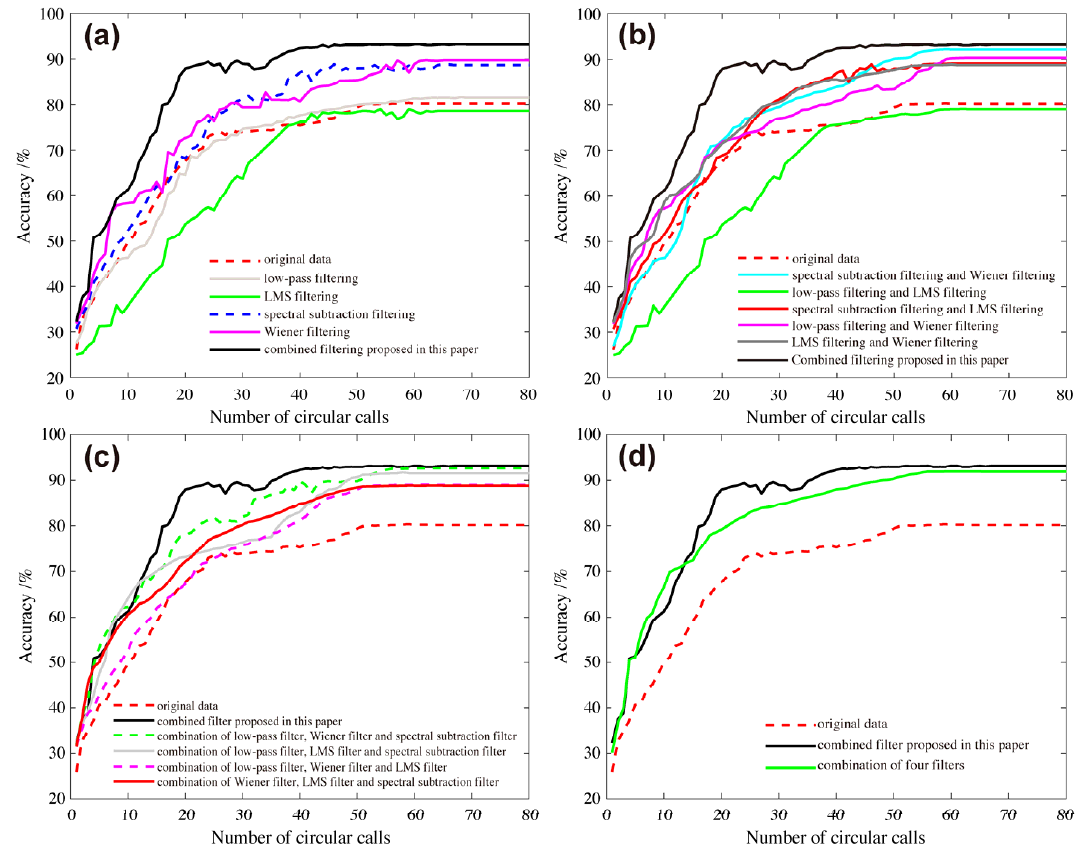
Figure 9. ( a ) Accuracy of thunder recognition using different filters and a combined spectral subtrac- tion filter with a low-pass filter, and ( b – d ) similar to ( a ) but for the results using combinations of two, three, and four